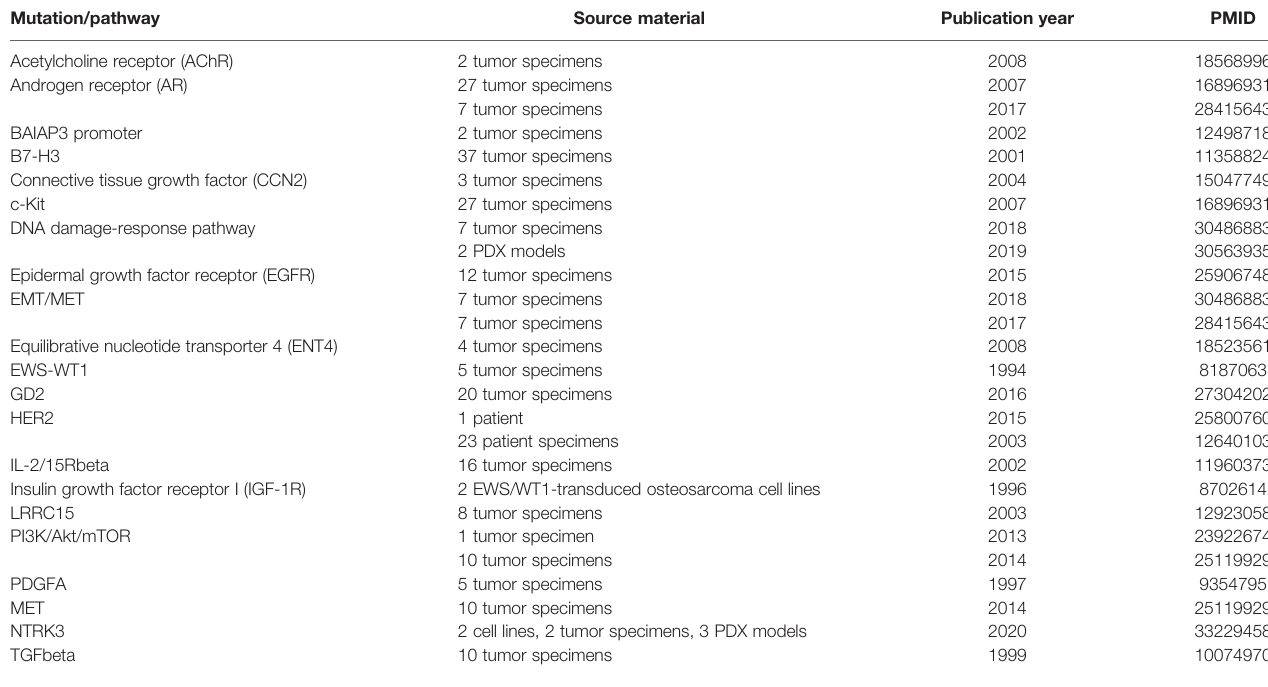
TABLE 2 | Mutations and dysregulated pathways in DSRCT.